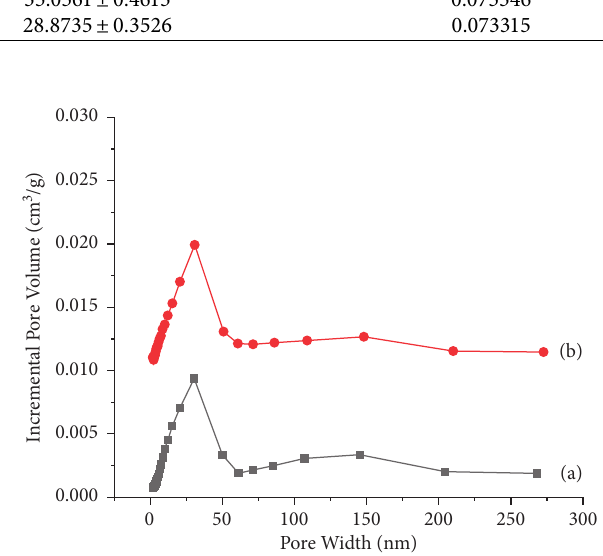
Figure 3: Pore volume distribution of the porous lactose before (A) drug loading and after (B) quercetin